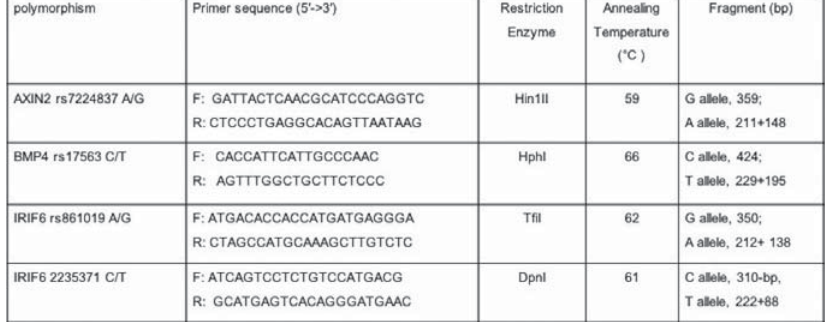
Figure 1- The primers and restriction enzymes used for detection of AXIN2, BMP4, and IRF6 polymorphisms using PCR-RFLP Table 2 - Frequency distribution of genotypes combinations for the IRF6 rs861019, and BMP4 rs17563, and AXIN2 rs7224837polymorphisms between patients with nonsyndromic cleft lip and/or cleft palate (NSCL/P) and control subjects